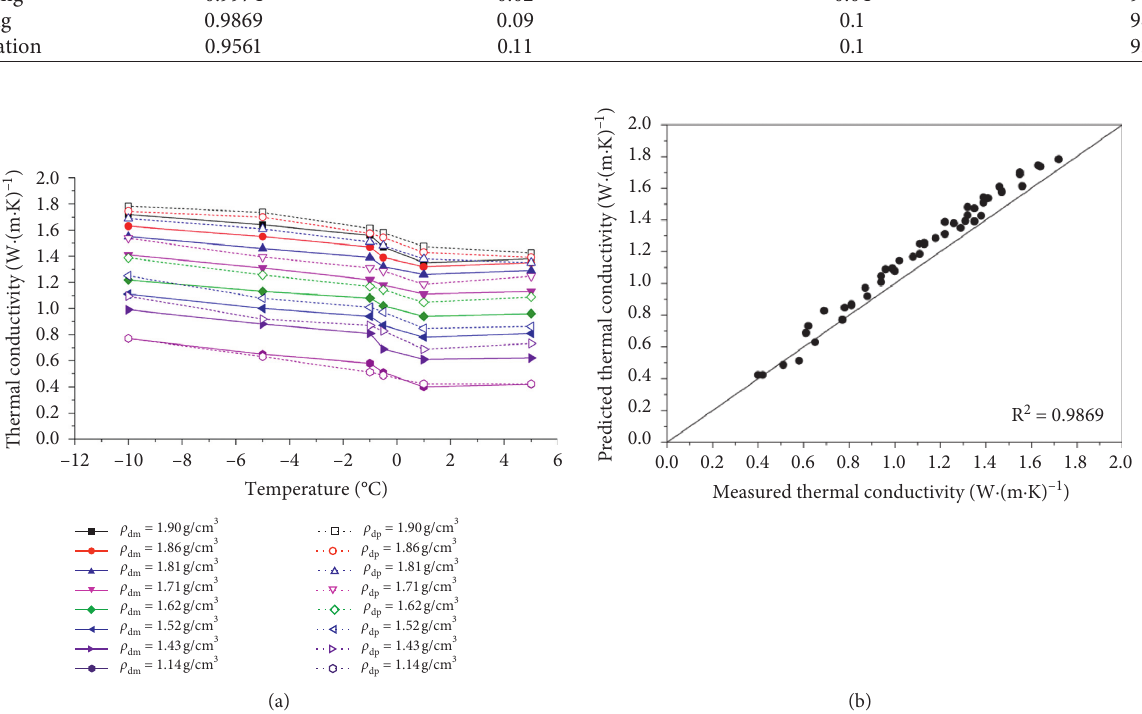
Figure 8: Comparison of the thermal conductivity of the soil specimens with the initial moisture content of 16% predicted by the model with the measured values. (a) Variation curve with temperature. (b) Fitting